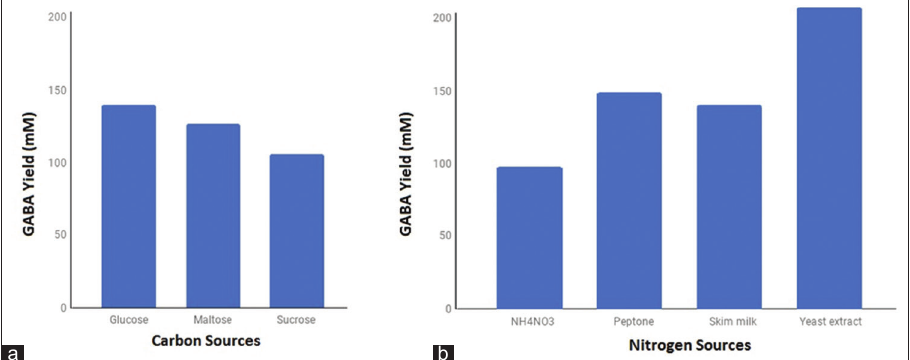
Figure-4: Effect of carbon (a) and nitrogen (b) sources on the γ-aminobutyric acid production by Lactobacillus plantarum N5.